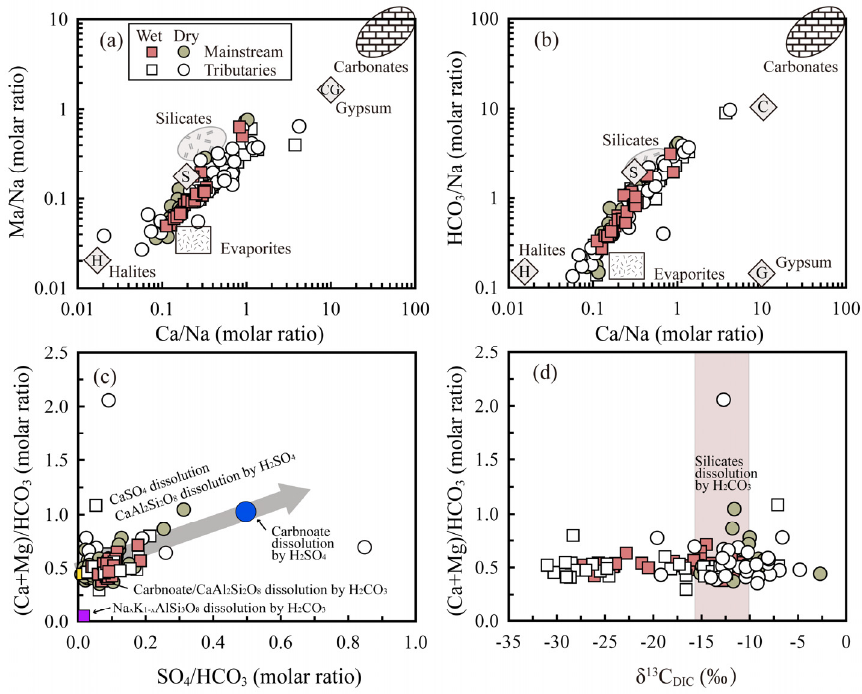
Figure 5. The elemental molar ratios showing the mixing relationships: ( a ) Mg/Na vs. Ca/Na; ( b ) HCO 3 /Na vs. Ca/Na; ( c ) (Ca + Mg)/HCO 3 vs. SO 4 /HCO 3 ; ( d ) (Ca + Mg)/HCO 3 vs. δ 13 C DIC .